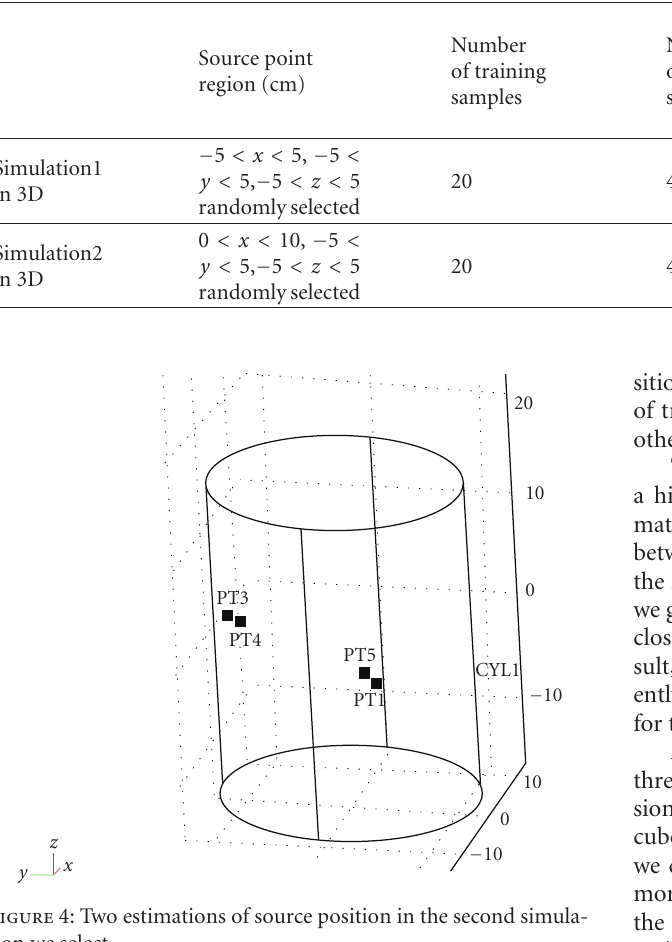
Table 2: Estimation of source position in the particular region.